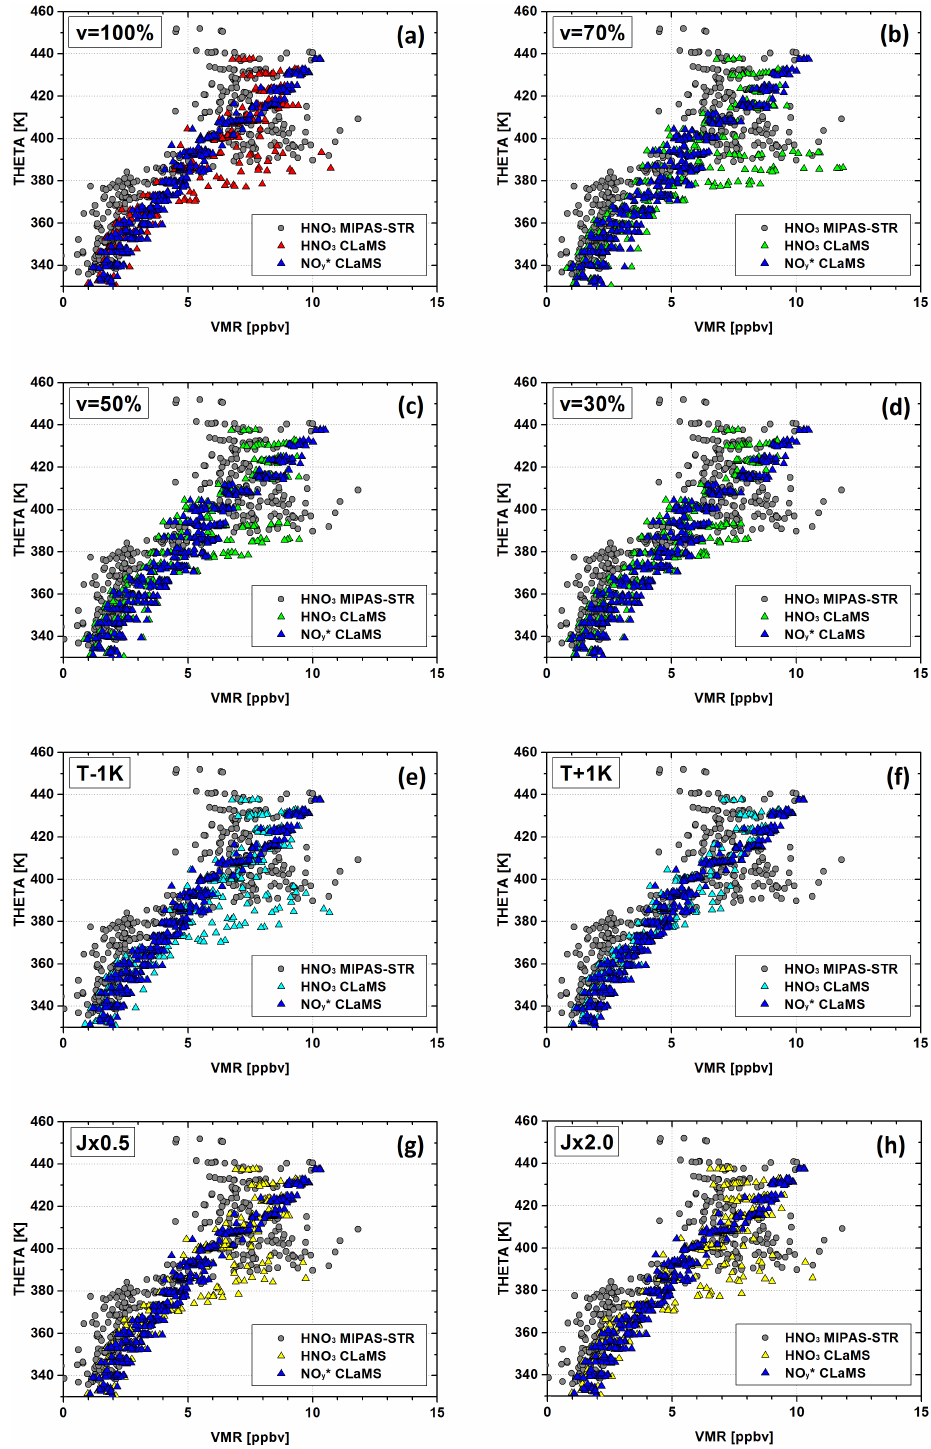
Figure 12. Comparison of the measured ensemble profile of gas-phase HNO 3 from MIPAS-STR with the CLaMS reference simulation ( v = 100%) and scenarios considering reduced settling velocities of NAT particles ( v = 70%, v = 50% and v = 30%), temperature biases of ± 1K ( T − 1K and T + 1K) and modified nucleation rates (J × 0.5 and J × 2.0) for the PSC flight on 25 January 2010. NO ∗ y corresponds to simulated passive NO y